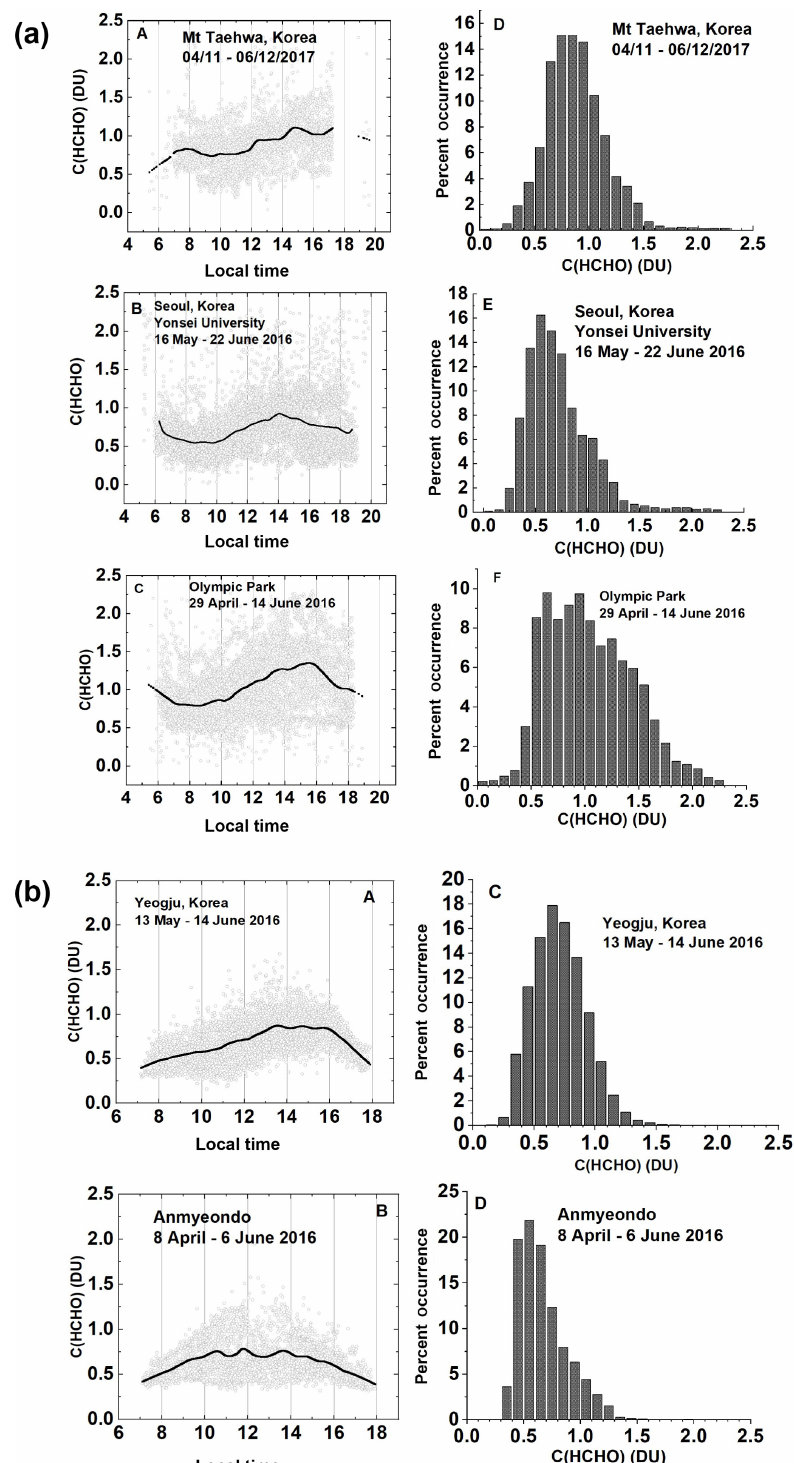
Figure 19. (a) Summary of total column HCHO for the stated dates during the KORUS-AQ campaign. The solid line is a Lowess(0.1) fit to the data. The sharp cutoffs in panels (a) , (b) , and (c) were caused obstructions of the direct sun from the PSI FOV in the afternoon. (b) Summary of total column HCHO for the stated dates during the KORUS-AQ campaign. Panels (a) and (b) represent the daily variation at a given local time. The solid line is a Lowess(0.1) fit to the data. Panels (c) and (d) show the frequency of occurrence (%) for different amounts of